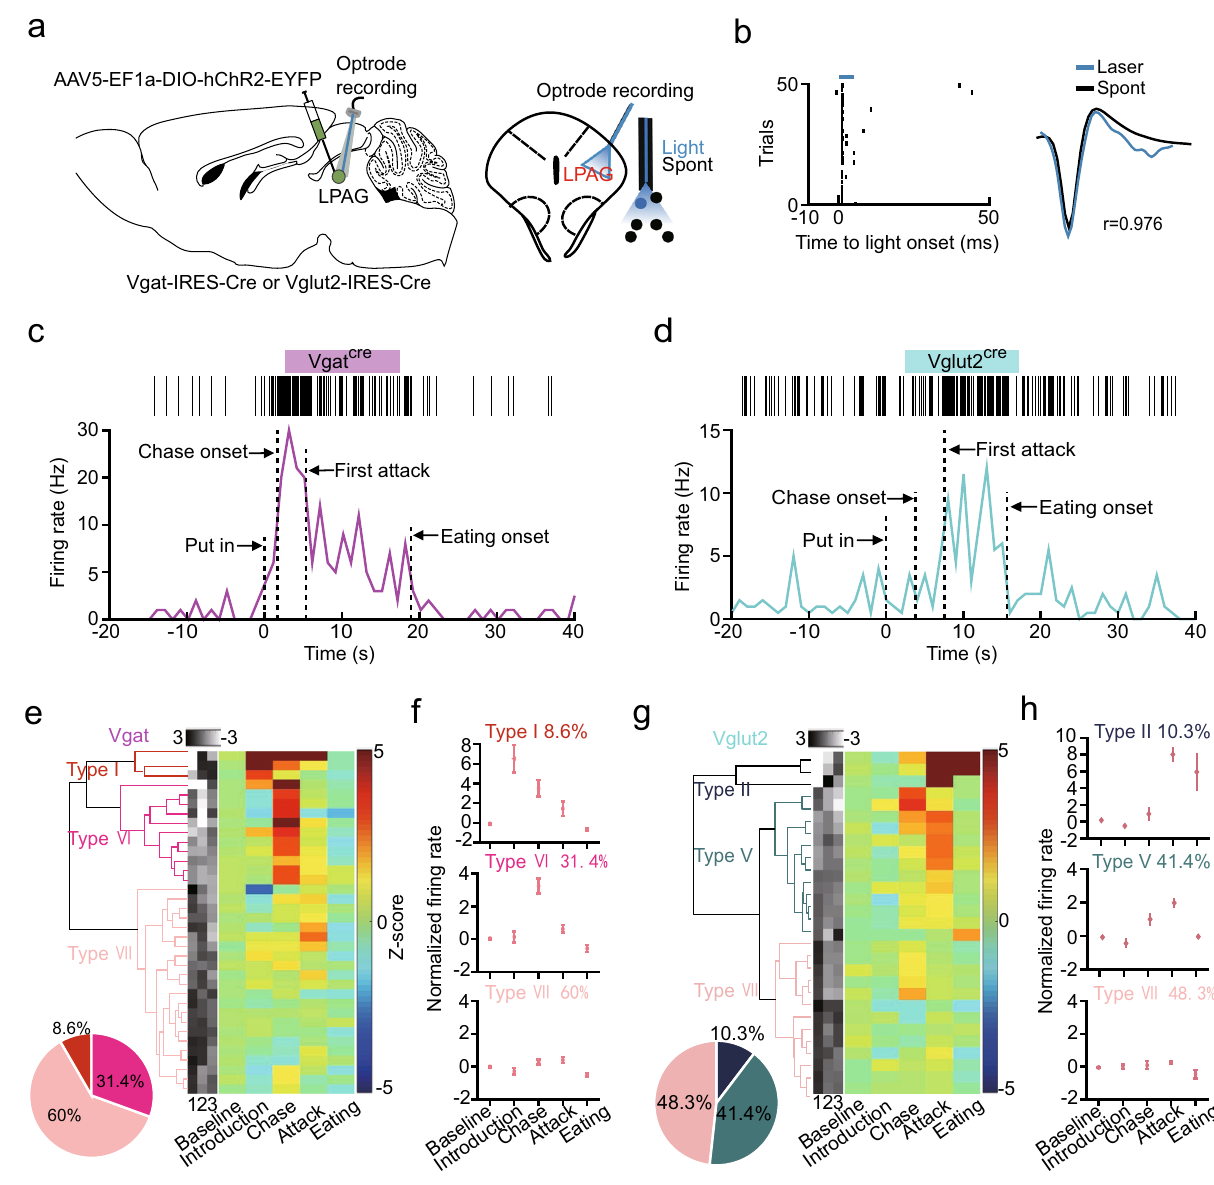
Fig. 2 LPAG Vgat and LPAG Vglut2 neurons are differentially recruited in different hunting phases. a Scheme of in vivo optrode recordings. b Left, spike raster for laser-evoked spikes of a ChR2-tagged neuron. The light pulse was shown in blue (5-ms duration). Right, comparison between light-evoked (blue) and spontaneous (black) spike waveform. c An example of the optogenetically identi fi ed LPAG Vgat neuron that fi red during different predatory phases. d An example of the optogenetically identi fi ed LPAG Vglut2 neuron that fi red during different predatory phases. e PCA and hierarchical clustering dendrogram classi fi ed LPAG Vgat neurons into three types. The z -score activity plots of 35 LPAG Vgat neurons tagged during different predatory phases were shown. f Z -score of fi ring rates in different predatory phases for each of the three types of LPAG Vgat neurons (type I: n = 3; type VI: n = 11; type VII: n = 21 neurons). g PCA and hierarchical clustering dendrogram classi fi ed LPAG Vglut2 neurons into three clusters. The z -score activity plots of 29 LPAG Vglut2 neurons tagged during different predatory phases were shown. h Z -score of fi ring rates in different predatory phases for each of the three types of LPAG Vglut2 neurons (type II: n = 3; type IV: n = 12; type VII: n = 14